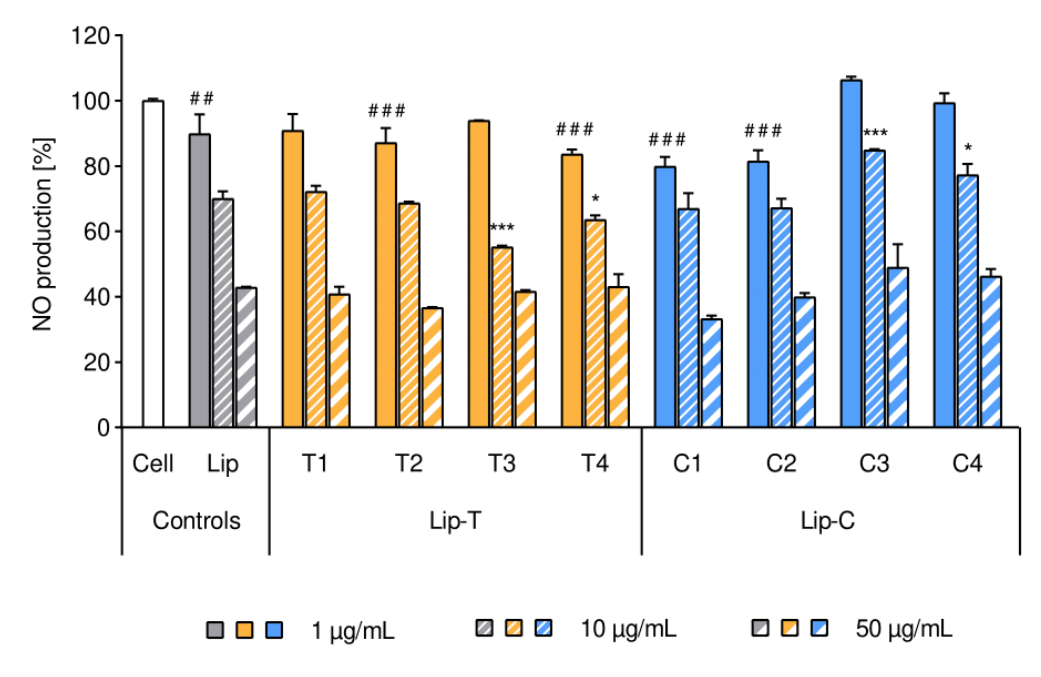
Figure 5. E ff ect of liposomes on the intrinsic inflammatory activity of RAW 264.7 macrophages. Intrinsic nitric oxide production was expressed in percentage from 0% (non-inflamed cells) to 100% (1 µ g / mL LPS-inflamed cell as control, white bar). Bars represent mean ± SD ( n = 3) and separate clusters refer to di ff erent liposomes in three concentrations of lipids (1, 10 and 50 µ g / mL per well). Tags of significance show deviance from the cell control (white bar) for all the lowest lipid concentration applied (1 µ g / mL): #: p < 0.05; ###: p < 0.001. All liposomes at the lipid concentration of 10 and 50 µ g / mL showed the highest significance of p < 0.001 (not marked in the figure). Stars of significance indicate deviance from the respective empty liposome control (Lip, gray cluster): *: p < 0.05; ***: p < 0.001. Abbreviations: Lip refers to liposomes; Lip-T and Lip-C refer to the dye-containing liposomes with T (lipid dye) and C (surface lipid dye) respectively; NO is nitric oxide; SD is standard deviation.